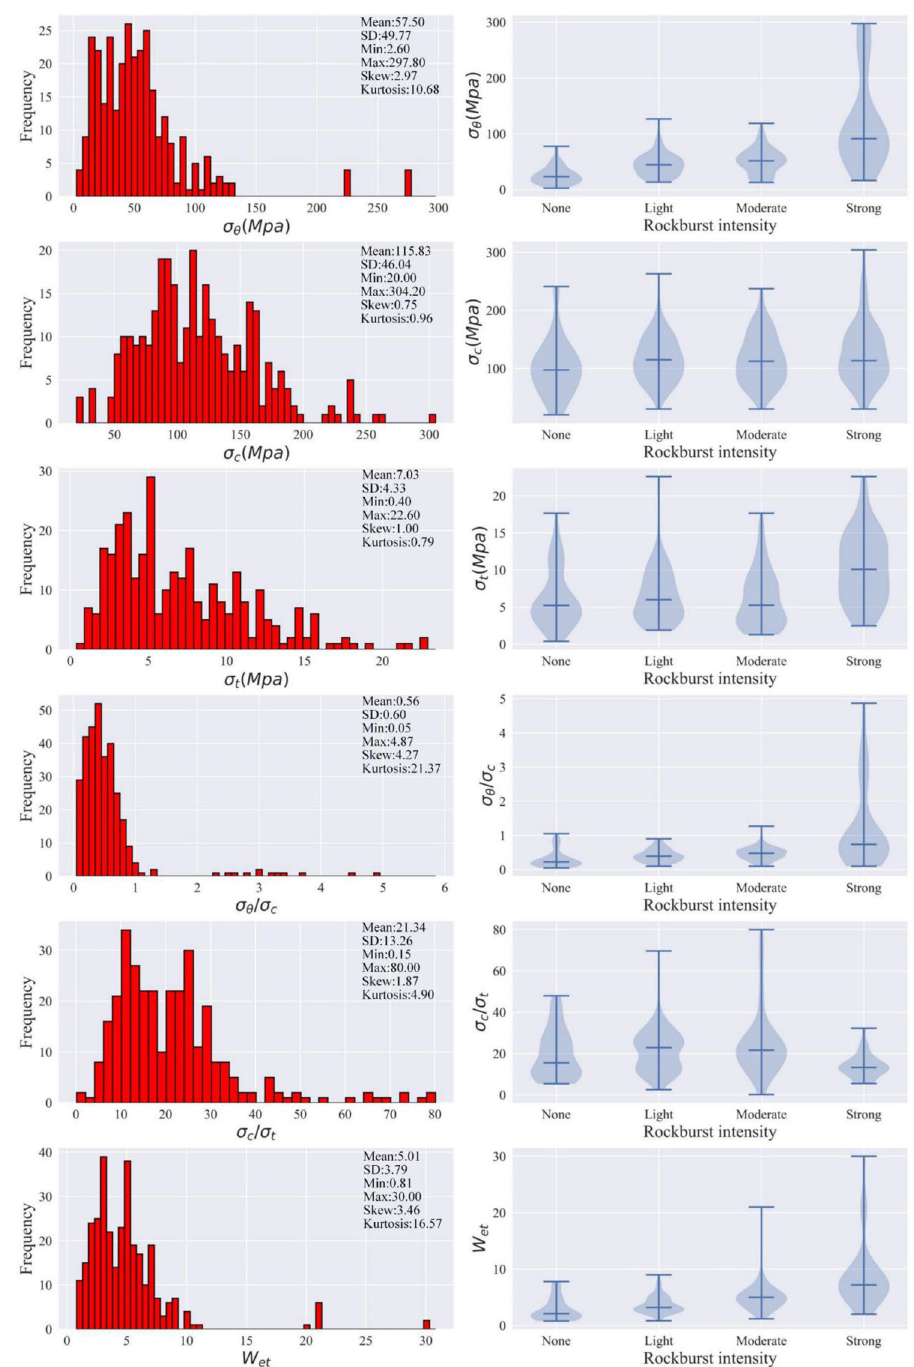
Figure 3. The histograms and violin plots of six